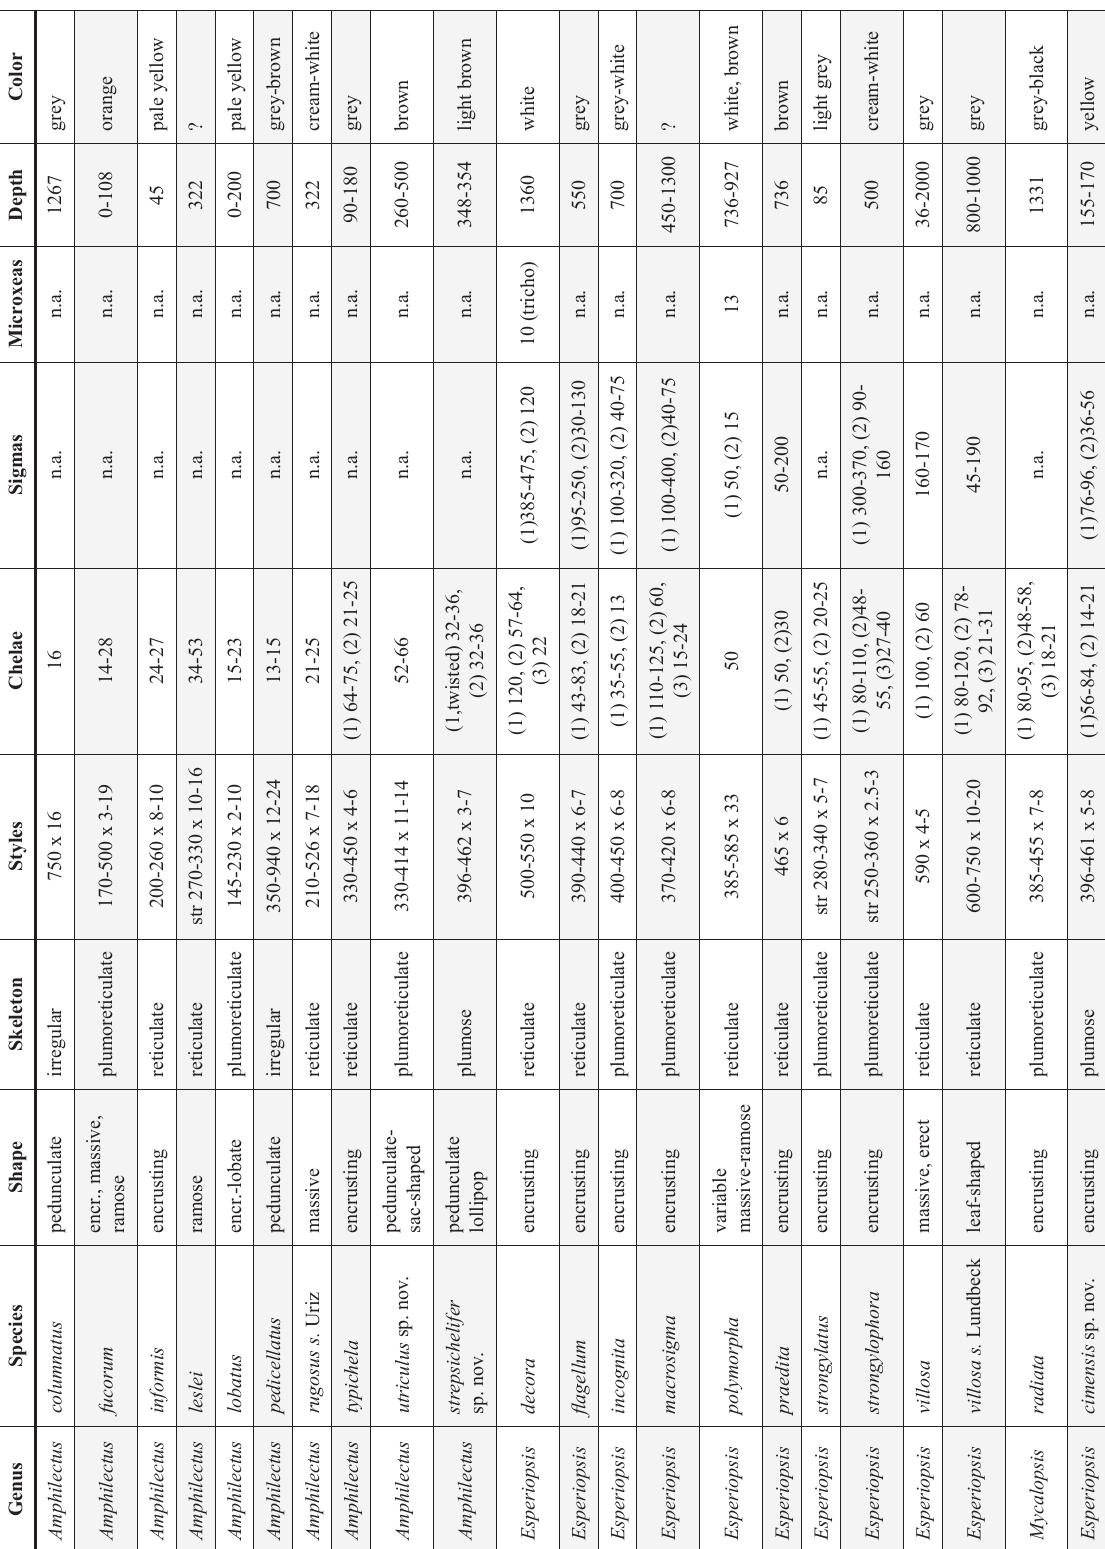
Table 1. Summary of characters of Atlantic sponges belonging to genera Amphilectus Vosmaer, 1880 and Esperiopsis Carter,